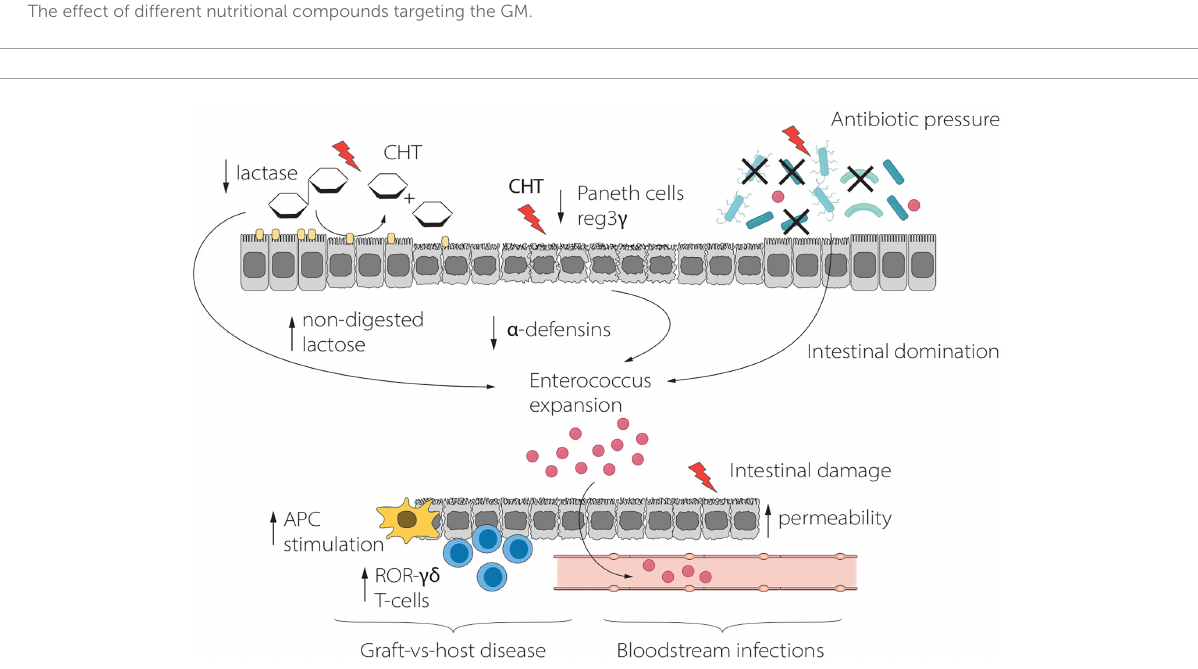
FIGURE3 Schematic representation of the relationship between Lactose, Enterococcus and clinical outcome during HSCT. Enterococcus expansion, driven by lactose, promotes inflammation and GvHD, whereas translocation through the damaged intestinal mucosa results in BSI. APC, Antigen Presenting Cell; CHT,